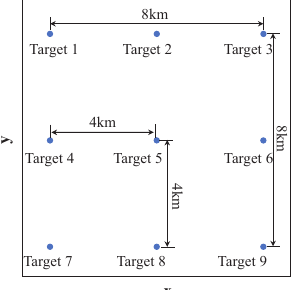
Figure 6. Positions of nine